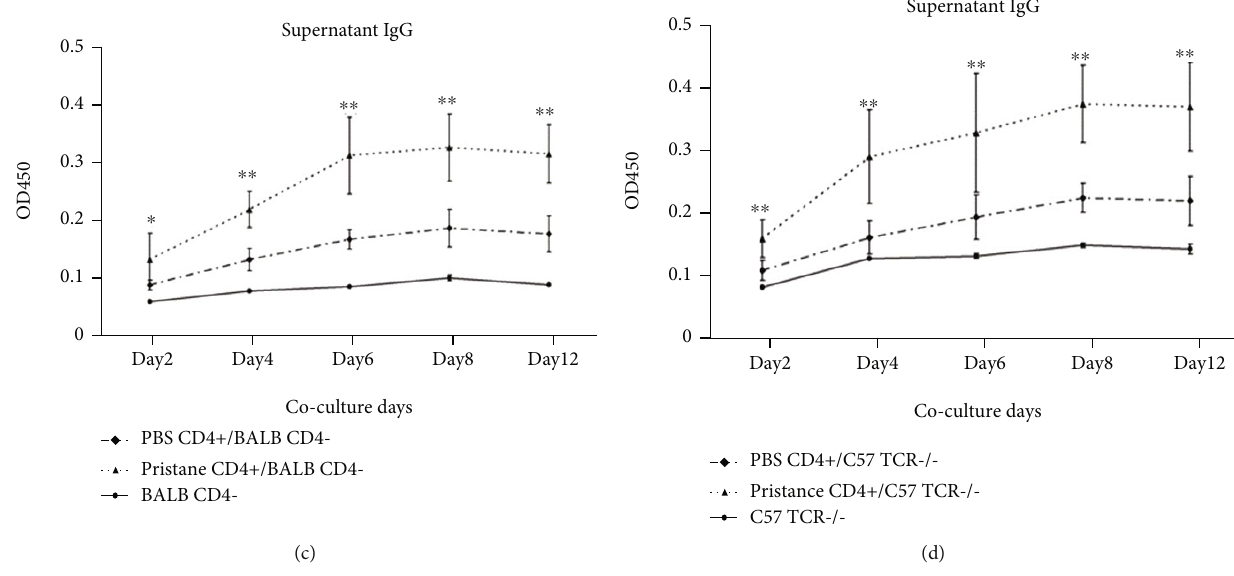
Figure 4: Activated CD4 + T cells can promote IgG production in an MHC-independent way. CD4 + T cells were sorted from PBS and pristane-treated BALB/c mouse (6 months later) by MACS. 3 × 10 4 CD4 + T cells were cultured with 9 × 10 4 CD4 - splenocytes derived from wild-type BALB/c or TCR α -/- mice (on a C57BL/6 background). Total IgM (a, b) and IgG (c, d) levels in the supernatants at di ff erent time points (days 2, 4, 6, 8, and 12) were quanti fi ed by ELISA. Each group had at least six mice for the analysis. ∗ p < 0 : 05 ; ∗∗ p < 0 : 01